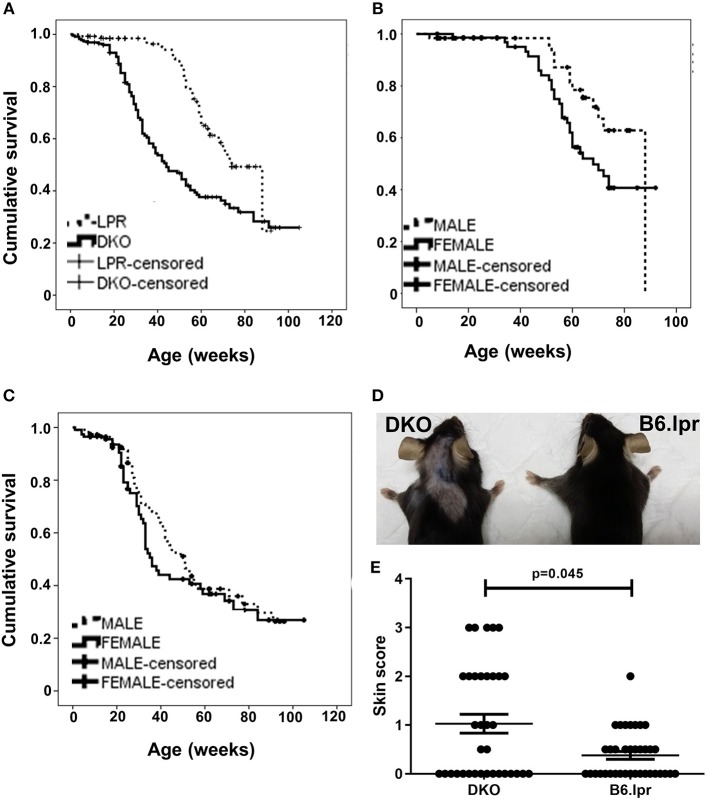
Survival and cutaneous lesions in DKO and B6.lpr mice. (A) Survival curves of B6.lpr and DKO mice based on an observation period of 22 months. (B) Survival curves of B6.lpr mice with segregation based on gender. (C) Survival curves of DKO mice with segregation based on gender. Data in (A–C) are censored. (D) A representative example of more severe skin lesions in a DKO than a B6.lpr mouse. Left: 14-week old male DKO mouse. Right: 12-week old male B6.lpr mouse. (E) Dermatitis skin scores of DKO and B6.lpr mice. Each dot represents one mouse.